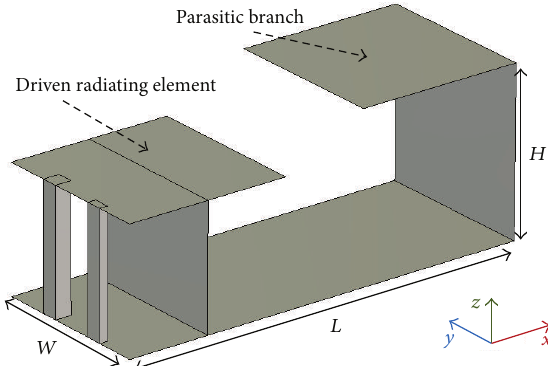
Figure 6: A PIFA characterized by a driven (fed) radiating element separated by a small gap from a parasitic branch